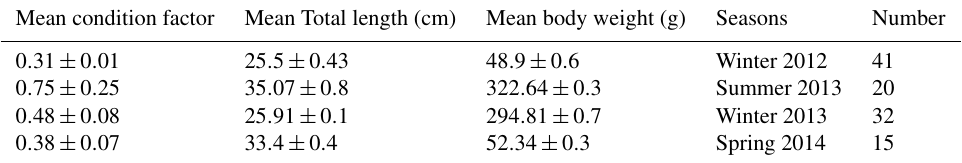
Table 1. Number, seasons and means body weight (BW), total length (TL) and condition factor in Persian Sturgeon (Mean ±